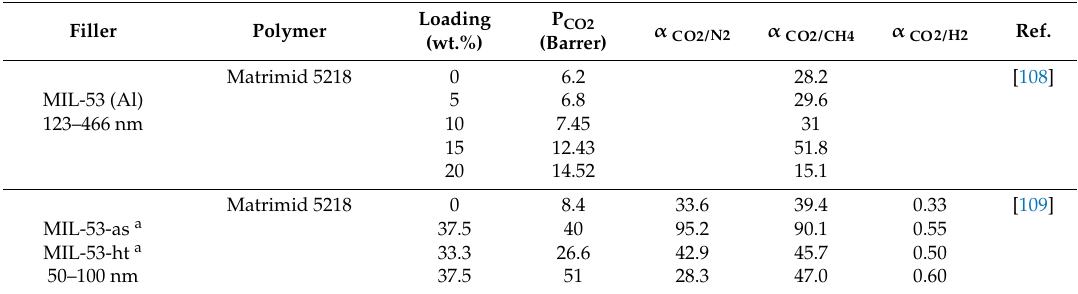
Table 4. Gas separation performance of MIL-based mixed matrix membranes (operating conditions ranging within 1–5 bar, 20–35 ◦ C, unless differently